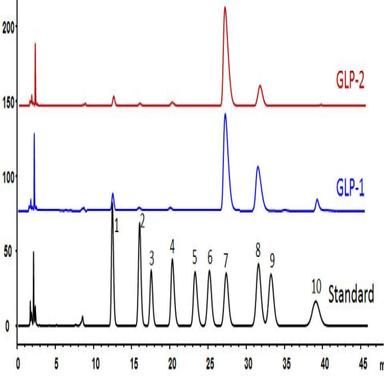
The HPLC chromatogram of monosaccharide compositions analysis. (1, Man; 2, GlcN; 3, Rha; 4, GlcA; 5, GalA; 6, GalN; 7, Glc; 8, Gal; 9, Xyl; 10, Fuc).